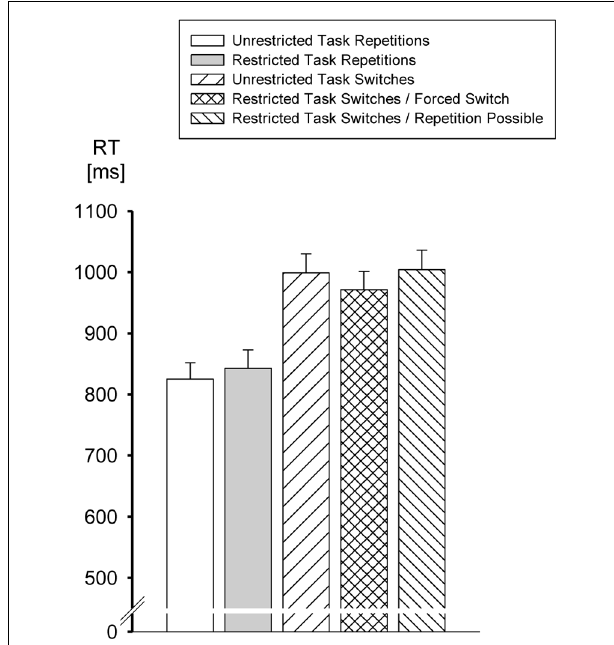
FIGURE 2 | Mean task execution RTs as a function of TaskTransition andTask Choice. Error bars represent